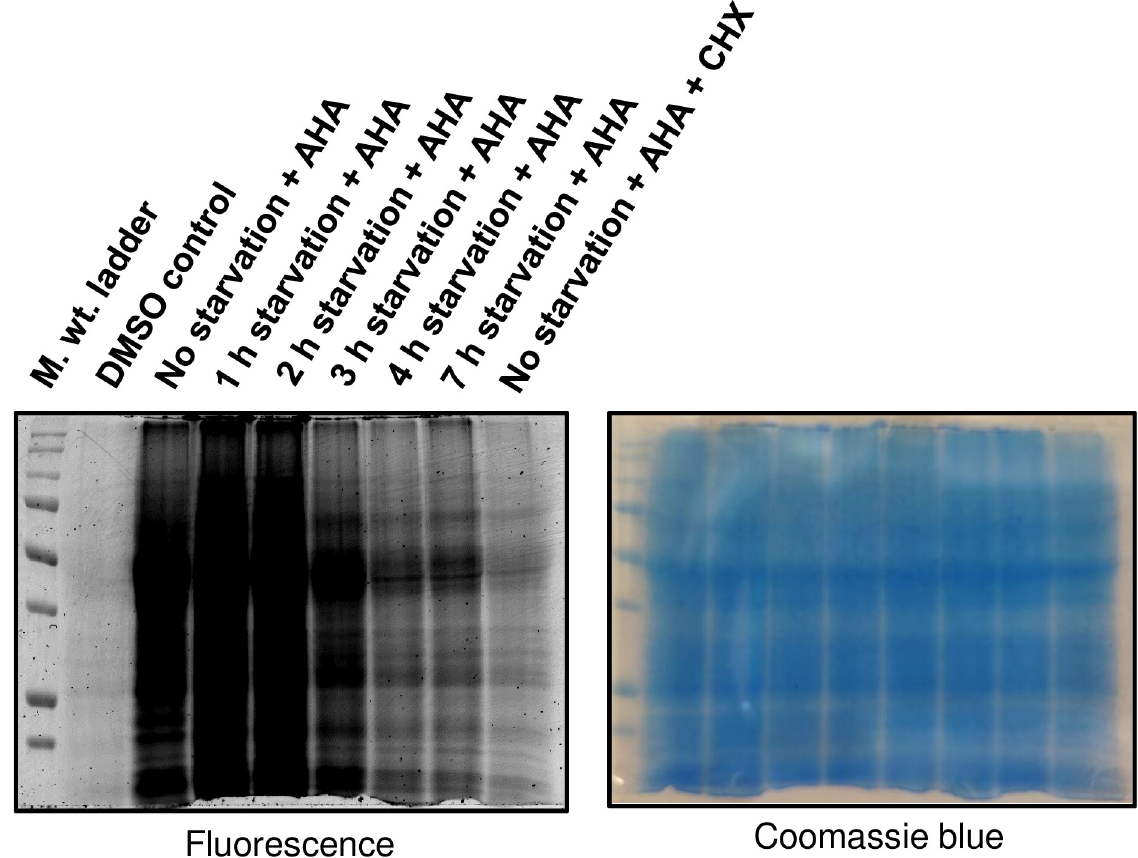
Fig 2. BONCAT in L . mexicana promastigotes under starvation. Promastigotes were cultured in methionine-free Schneider’s medium (30 minutes) prior to incubation in DPBS for different time periods (1 hour to 7 hours). The starved parasites were treated with AHA (50 μ M; lanes 3 to 9) or DMSO (control; lane 2) with (lane 9) or without CHX (10 μ M) for the last 1 hour of starvation and the NSPs were profiled by in-gel fluorescence scanning following click chemistry with a TAMRA-Alkyne. A Coomassie blue staining of the same gel that demonstrates even loading across the gel lanes is shown on the right